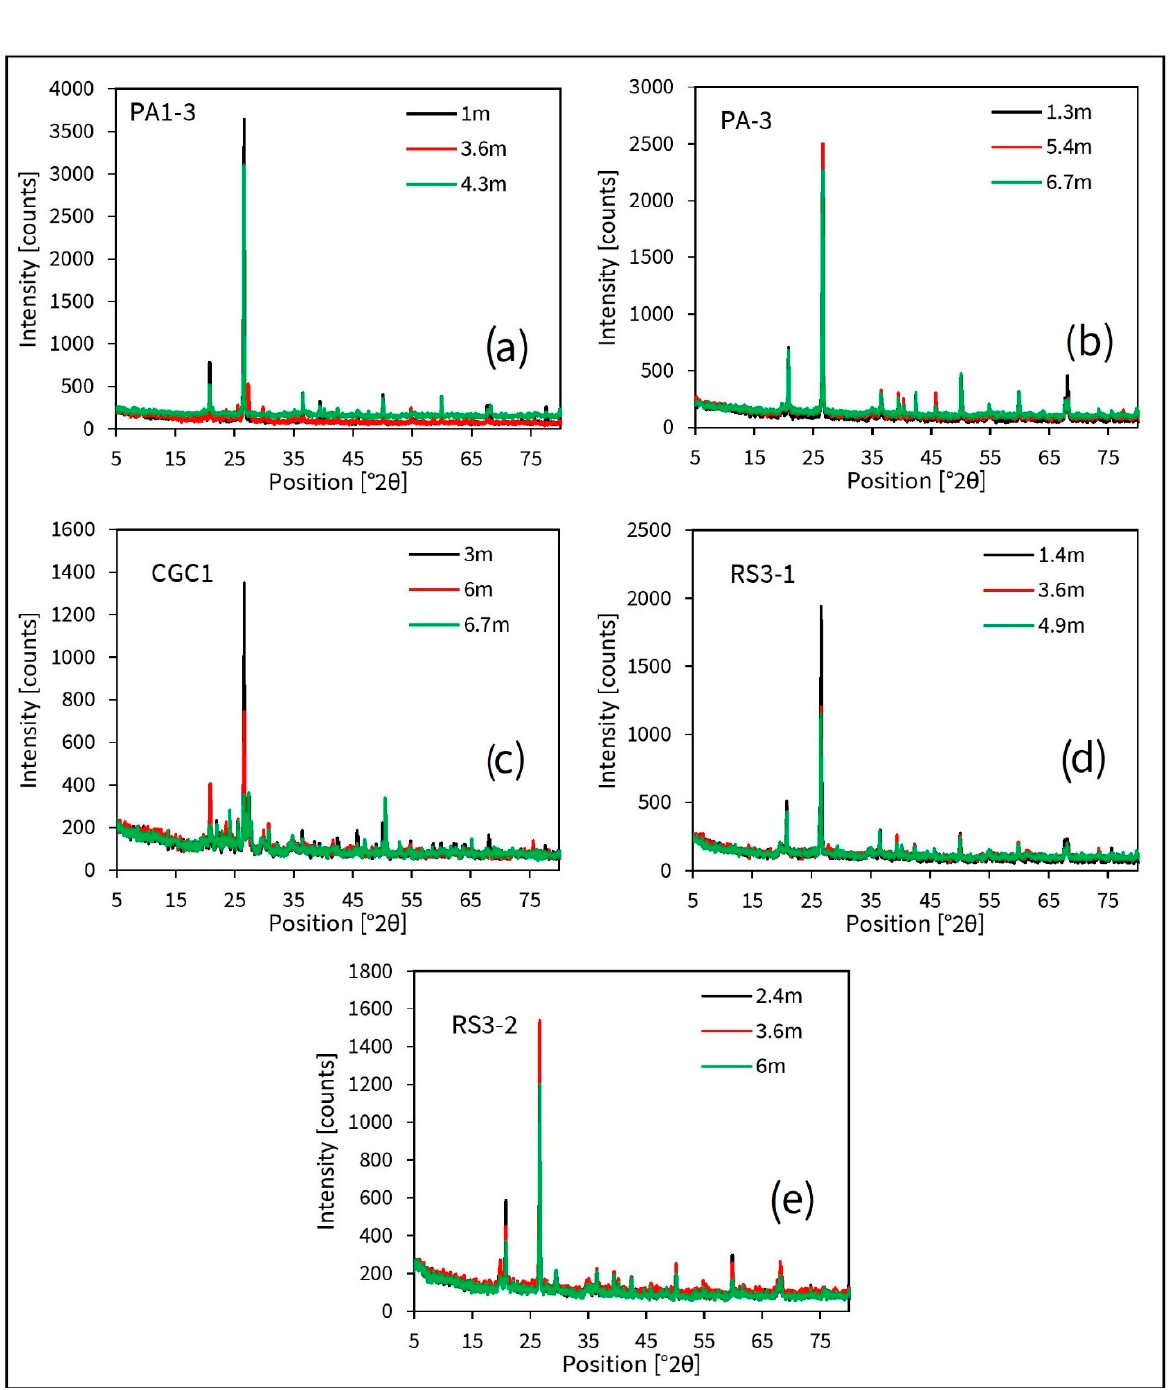
Figure 11. XRD peaks of the sediments from different boreholes at different depths beneath ( a , b )—Pleistocene alluviums; ( c )—Chotanagpur Gneissic complex; ( d , e )—residual soils. The lithology of the area plays a dominant role in the F distribution in the sediments.